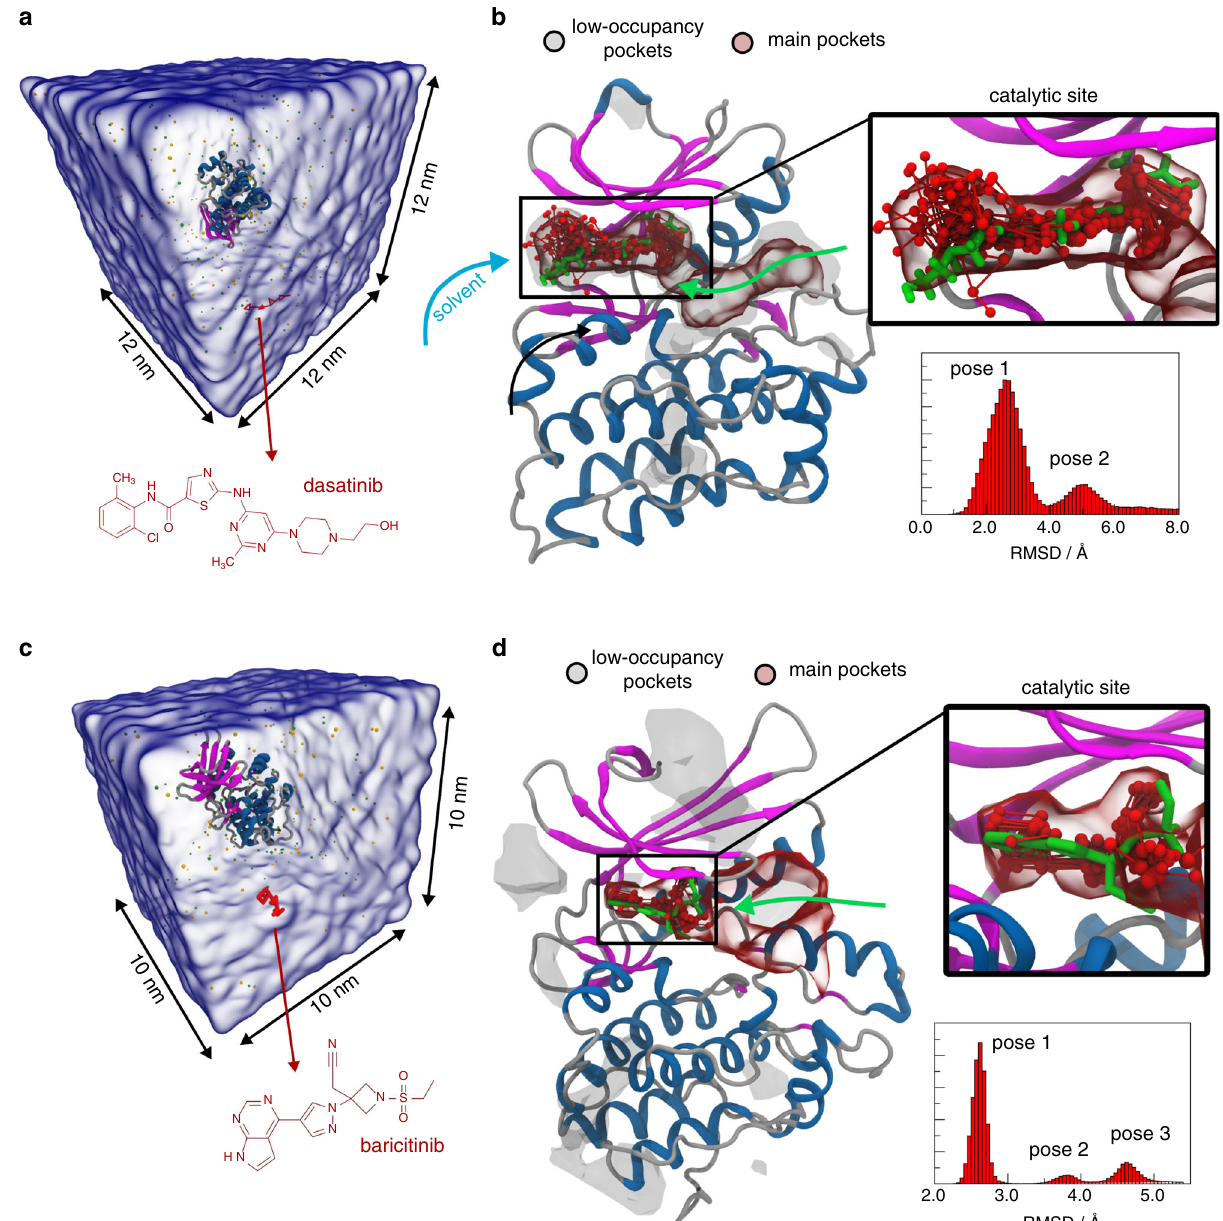
Fig. 4 Unbiased binding simulations of dasatinib to c-Src and baricitinib to AAK1 at the CG Martini level. a Simulation box containing the kinase domain (residues 260 – 533) of c-Src and one dasatinib molecule (red) solvated in water (transparent blue surface). b Crystal structure of c-Src (pdb code: 1Y57) with bound dasatinib (green). In addition, several CG snapshots of the bound dasatinib (red), the density in the main binding pocket (transparent red isosurface), and the density in several low-occupancy pockets (transparent gray isosurfaces) are shown. The two binding pathways observed are depicted as blue and green arrows. The histogram of the RMSD of dasatinib and the contact protein beads is depicted on the lower right. c Simulation box containing the AAK1 and one molecule of baricitinib (red) solvated in water (transparent blue surface). d Crystal structure of AAK1 (pdb code: 5L4Q) with the binding position of baricitinib taken from a homologous kinase crystal structure (pdb code: 4W9X). In addition, several CG snapshots of bound baricitinib (red), the density in the main binding pocket (transparent red isosurface), and the density in the low-occupancy pockets (transparent gray isosurface) are shown. The green arrow depicts the binding pathway. The histogram of the RMSD of baricitinib and the contact protein beads is depicted on the lower